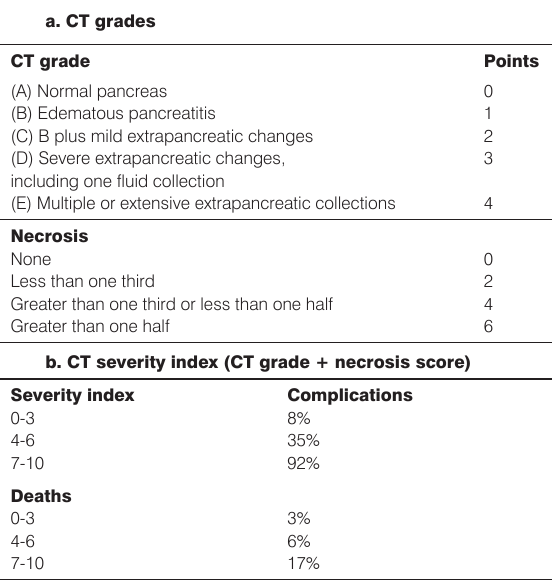
Table 2. CT grading of severity. Modified from the International Associa tion of Pancreatology and based on the paper of Blathazar et al [ 8 ]